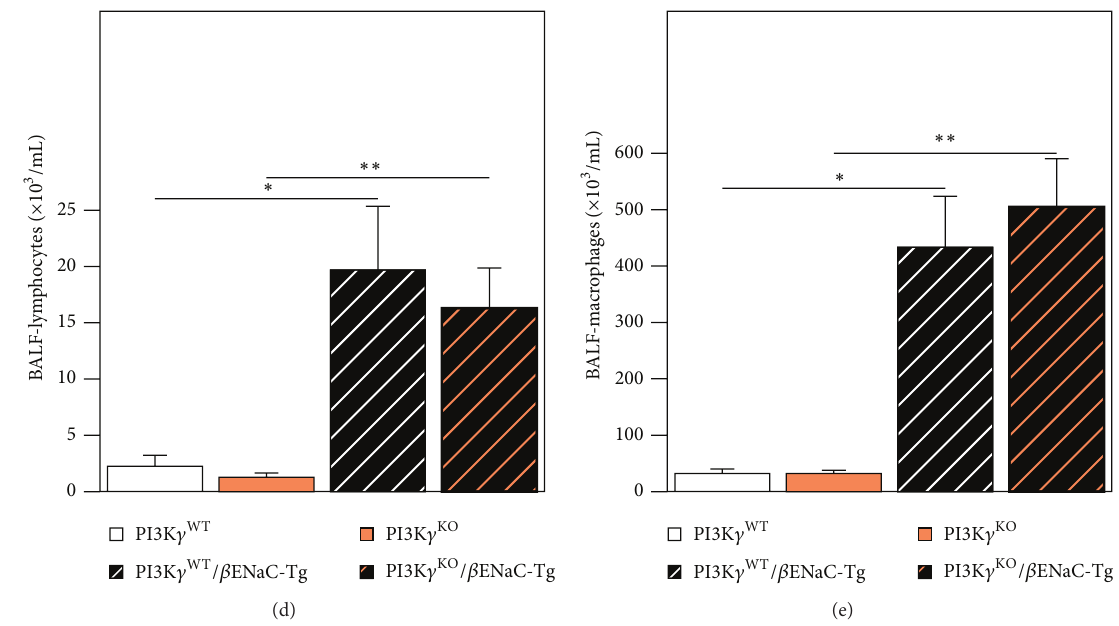
Figure 1: Effect of genetic deletion of PI3K 𝛾 on mortality and airway inflammation in 𝛽 ENaC-Tg mice . (a) Survival curves for the different groups of mice studied ( 𝑃 < 0.05 ). (b) Neutrophil numbers were assessed in BALF of PI 3 K 𝛾 WT , PI 3 K 𝛾 WT / 𝛽 ENaC-Tg, PI 3 K 𝛾 KO , and PI 3 K 𝛾 KO / 𝛽 ENaC-Tg mice. Neutrophils are expressed as cell numbers per mL of BALF ( 𝑛 = 10 mice for each group). Comparison between the different groups was performed by one-way analysis of variance. ∗∗∗ 𝑃 < 0.001 PI 3 K 𝛾 WT versus PI 3 K 𝛾 WT / 𝛽 ENaC-Tg and ∗∗∗ 𝑃 < 0.001 PI 3 K 𝛾 WT / 𝛽 ENaC-Tg versus PI 3 K 𝛾 KO / 𝛽 ENaC-Tg. (c) Immunofluorescent detection of neutrophils in lung tissues of PI 3 K 𝛾 WT / 𝛽 ENaC- Tg, PI 3 K 𝛾 KO , and PI 3 K 𝛾 KO / 𝛽 ENaC-Tg mice. Neutrophils were stained by using monoclonal rat antibodies to neutrophils (clone 7/4, Acris) and nuclei with DAPI. (d) Lymphocyte numbers were assessed in BALF of PI 3 K 𝛾 WT , PI 3 K 𝛾 WT / 𝛽 ENaC-Tg, PI 3 K 𝛾 KO , and PI 3 K 𝛾 KO / 𝛽 ENaC- Tg mice. Lymphocytes are expressed as number of cells per mL of BALF ( 𝑛 = 10 mice for each group) ∗ 𝑃 < 0.05 PI 3 K 𝛾 WT versus PI 3 K 𝛾 WT / 𝛽 ENaC-Tg and ∗∗ 𝑃 < 0.01 PI 3 K 𝛾 KO versus PI 3 K 𝛾 KO / 𝛽 ENaC-Tg. (e) Macrophage numbers were assessed in BALF of PI 3 K 𝛾 WT , PI 3 K 𝛾 WT / 𝛽 ENaC-Tg, PI 3 K 𝛾 KO , and PI 3 K 𝛾 KO / 𝛽 ENaC-Tg mice. Macrophages are expressed as number of cells per mL of BALF ( 𝑛 = 10